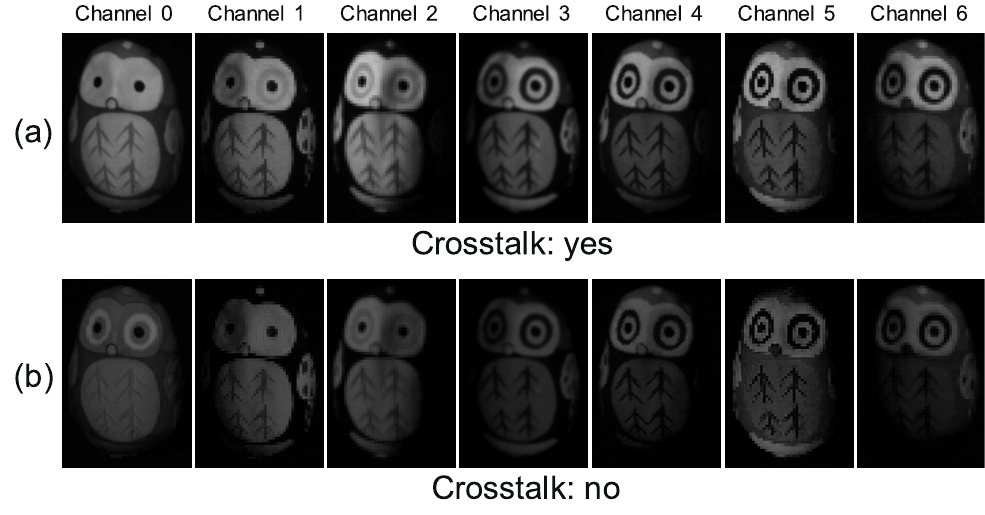
Figure 15. Obtained multi-band image [owl]: ( a ) Captured image and ( b ) image after cancelling channel crosstalk. If you look carefully, you may notice that the channel crosstalk is removed. However, the difference is difficult to recognize since the crosstalk is small as is shown in Figure 9.